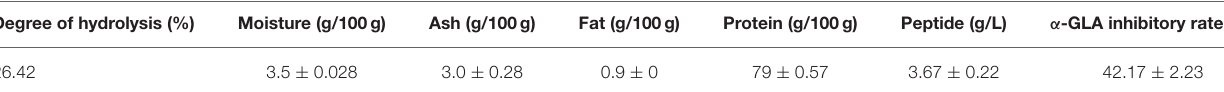
TABLE 1 | Expanded experiment of the preparation of MBPs and its physical and chemical properties.